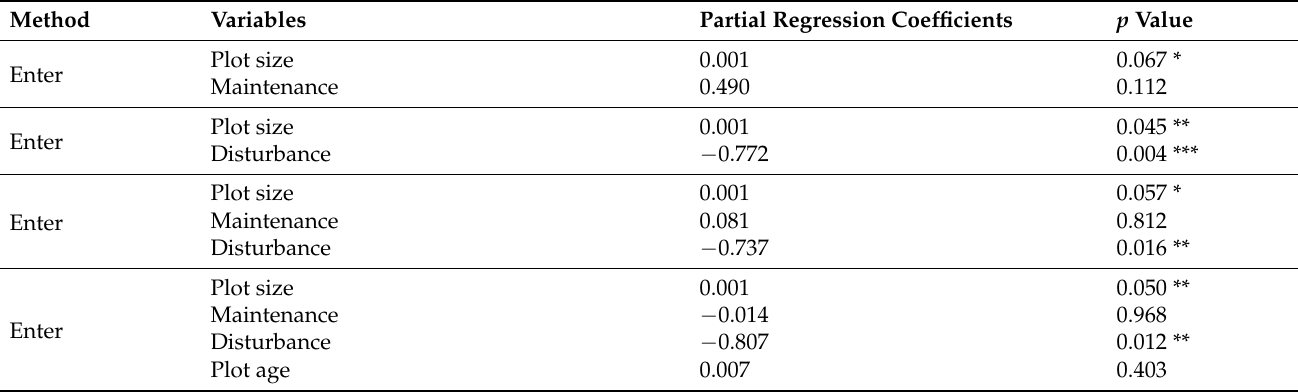
Table 3. Regression analysis of SOC stock across all sampled